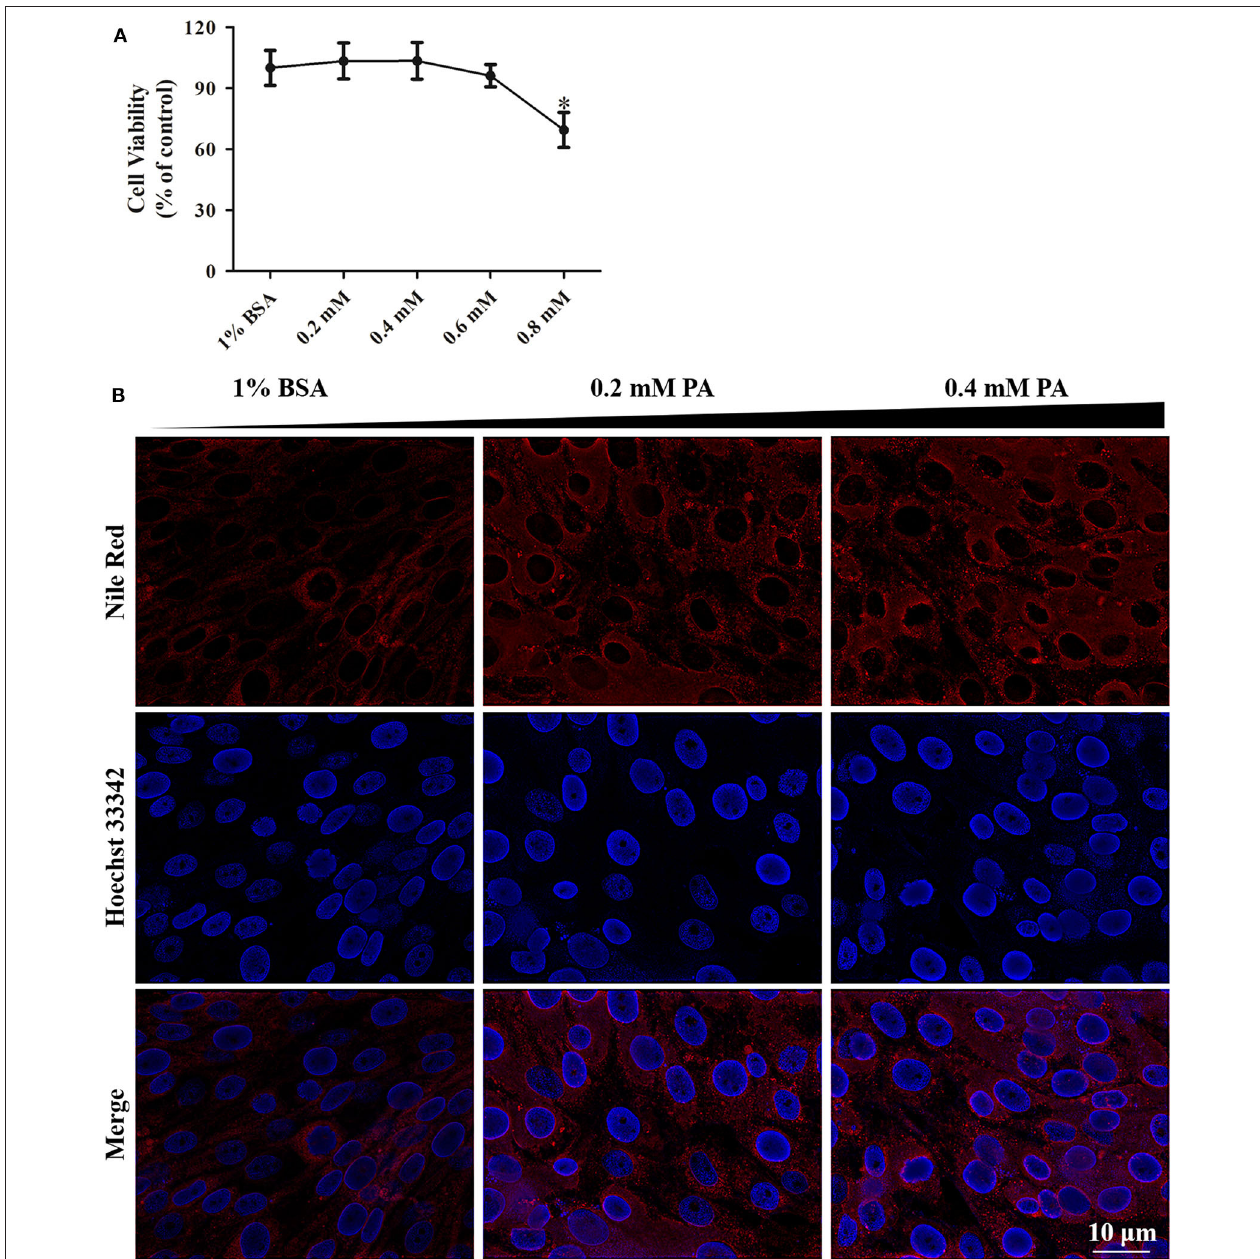
FIGURE 3 | Palmitic acid treatment had low cytotoxicity in GS cells. (A) WST-1 assay suggesting the effect of intracellular fat accumulation (dose-dependent) on cellular cytotoxicity of GS cells in culture. Cell viability is expressed as % of control cells (1% BSA). (B) Fluorescence microscopy showing the accumulation of lipids intracellular at 24h post-treatment by Nile Red staining (red). Cell nuclear was stained (blue) using Hoechst33342. The images were taken at 40 ×